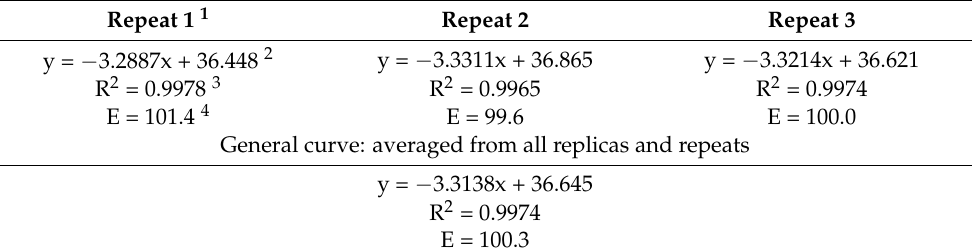
Table 6. Reliability of the quantification using iv RNA as